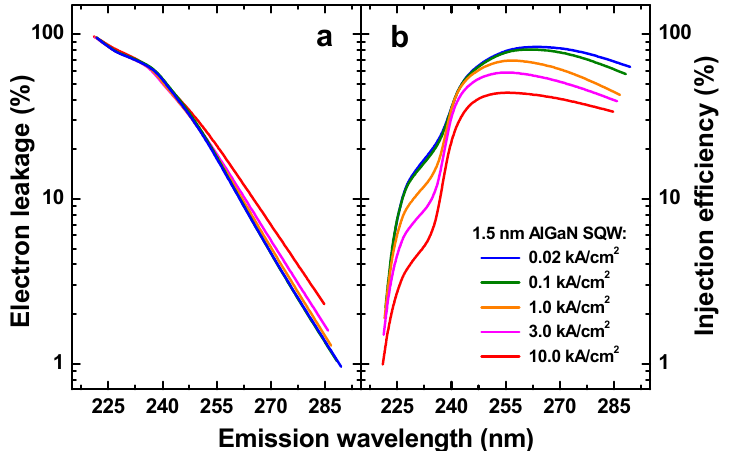
Figure 7. Percentage of electron leakage current of the total current flowing through the AlGaN SQW structure ( a ) and injection efficiency in the SQW ( b ) as a function of emission wavelength.